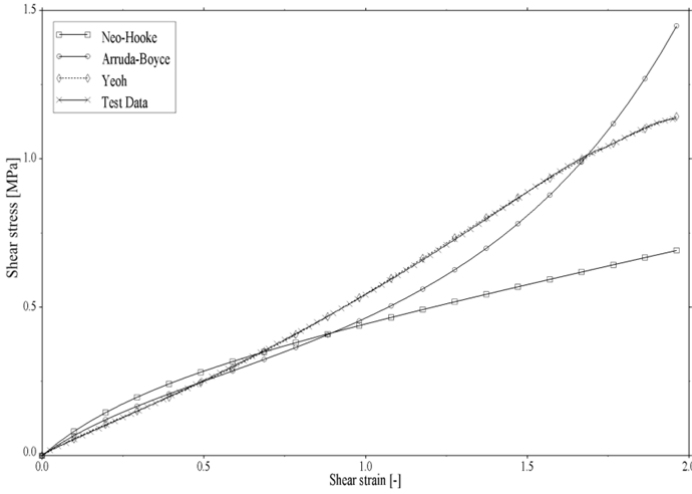
Fig. 10 Experimental data and material laws for Sikasil ® SG-500 under shear.